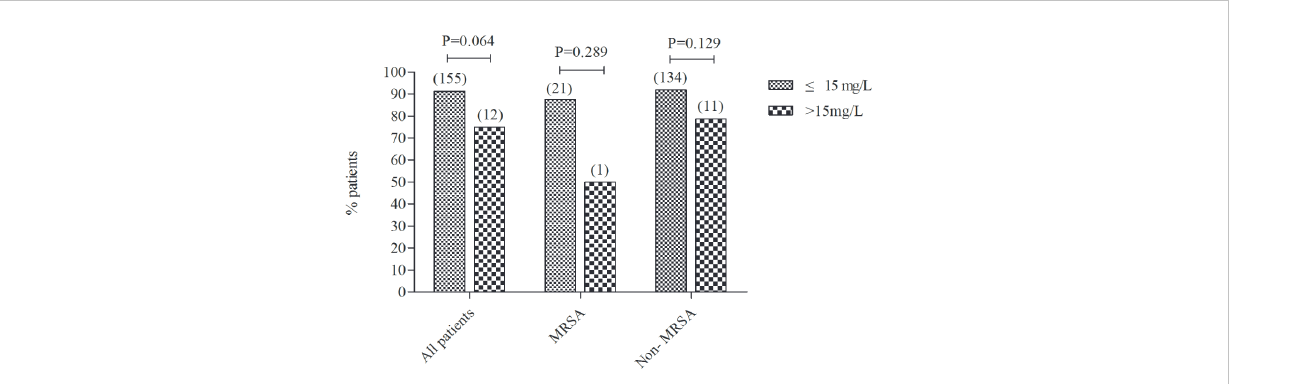
FIGURE 3 The treatment success rate between trough concentrations ≤ 15 mg/L and >15 mg/L in all enrolled patients, MRSA infection patients and non-MRSA infection patients. The number in brackets above the columns re fl ects the total number of children. MRSA, Methicillin-resistant Staphylococcus aureus